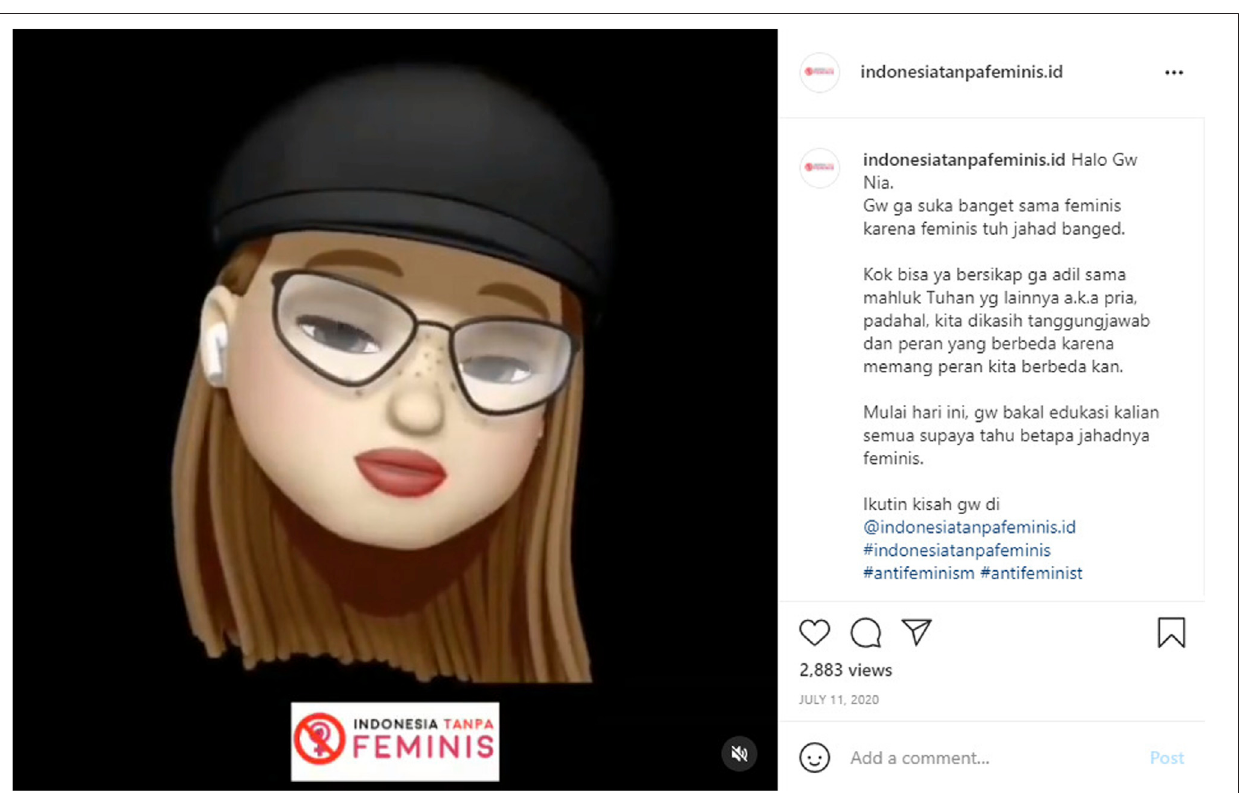
FIGURE 4 | The admin ’ s pro fi le who does not use hijab (Posted by @indonesiatanpafeminis.id on July 11, 2020).